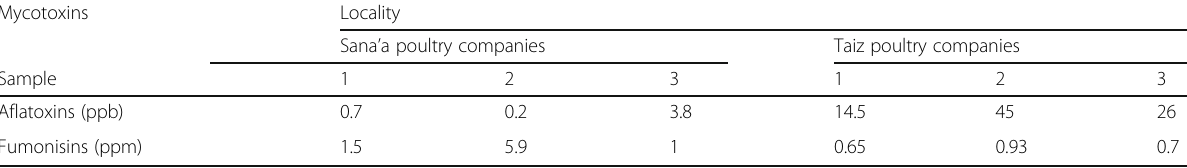
Table 4 Means of aflatoxins and fumonisins in ration samples collected from poultry ration supply companies